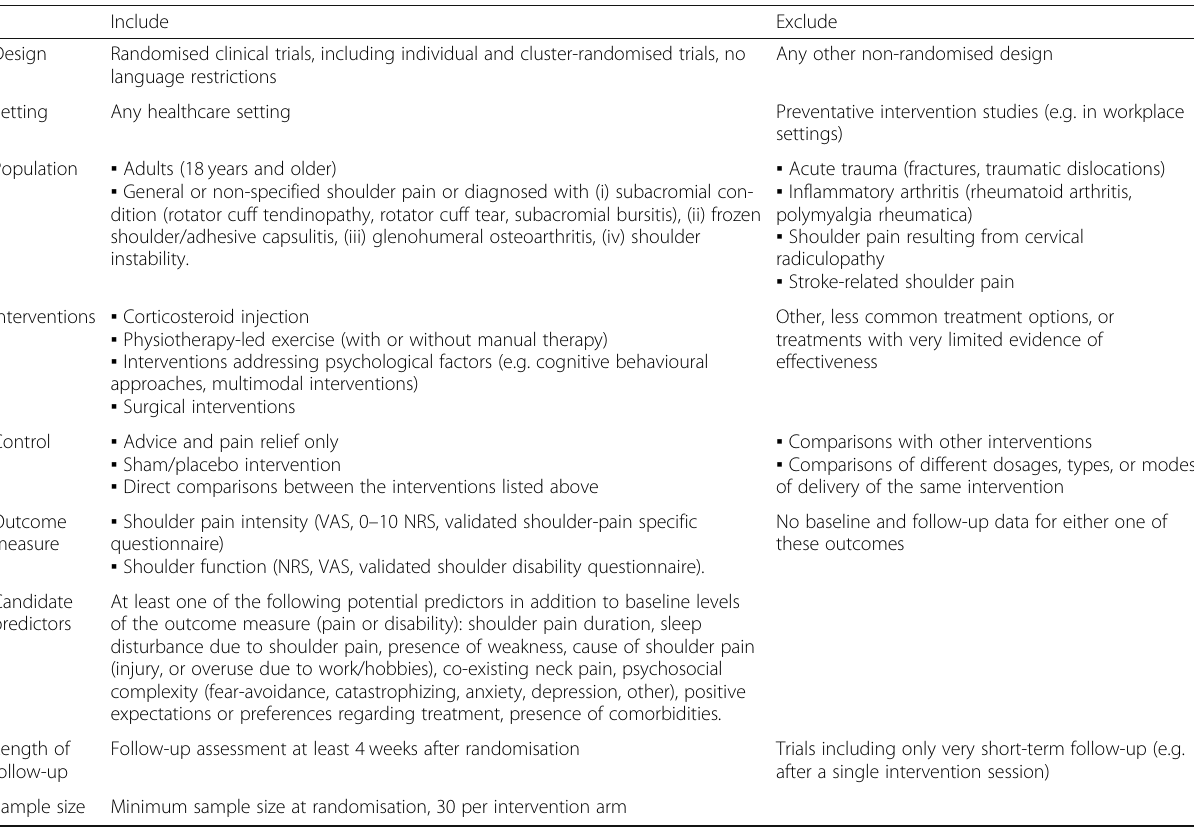
Table 1 Eligibility criteria for including trials in the IPD meta-analysis